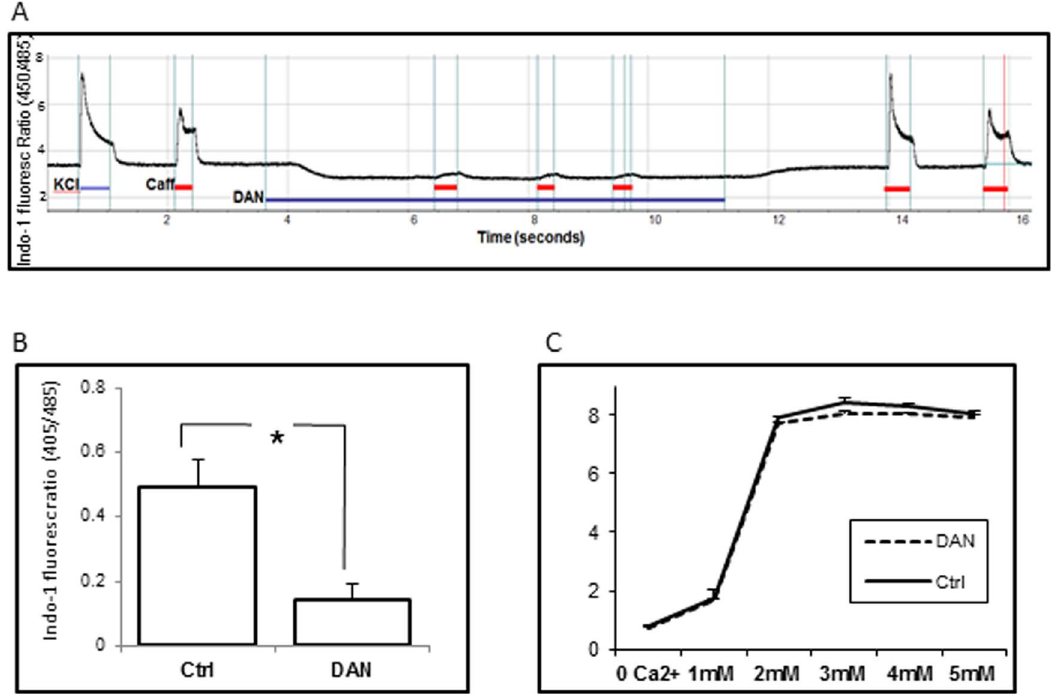
Figure 4. Effect of dantrolene on calcium transients. A) Depolarization with 60 mM KCl and 20 mM caffeine in normal buffer, followed by exposure to sequential exposures to caffeine in the presence of 10 m M dantrolene. B) The amplitude of the caffeine transient in the absence or presence of dantrolene. Note that dantrolene almost completely inhibits the ability of the myotubes to respond to caffeine (p , 0.05) and lowers the cytoplasmic calcium concentration of resting myotubes. C) Indo-1 fluorescence at increasing calcium concentration, in the presence or absence of 10 m M dantrolene. Note that there was no direct effect of dantrolene on Indo-1 fluorescence.